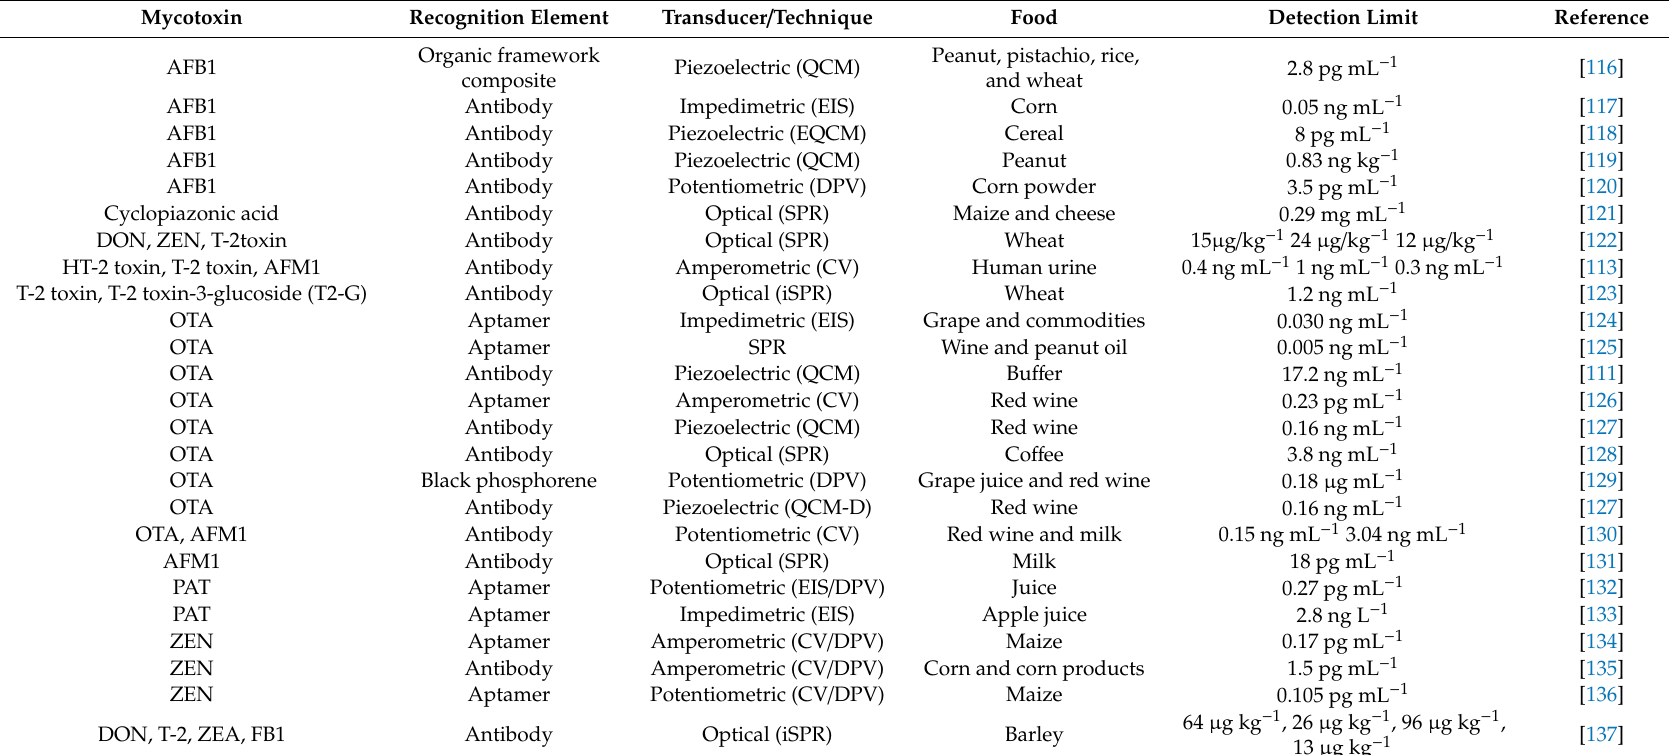
Table 5. Use of biosensors in mycotoxin detection with some